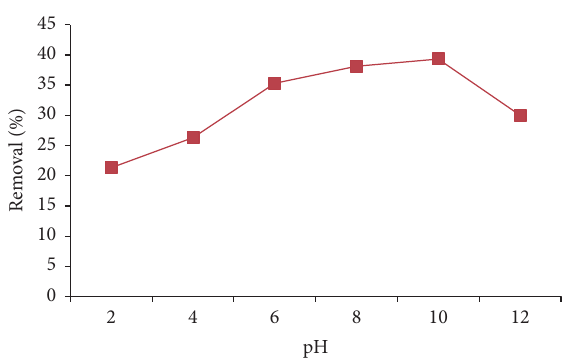
Figure 6: Effect of TiO 2 /GAC composite dosage on the degradation of furfural. Irradiation time: 40 min, initial furfural concentration: 300 mg/L, and initial pH: 10.